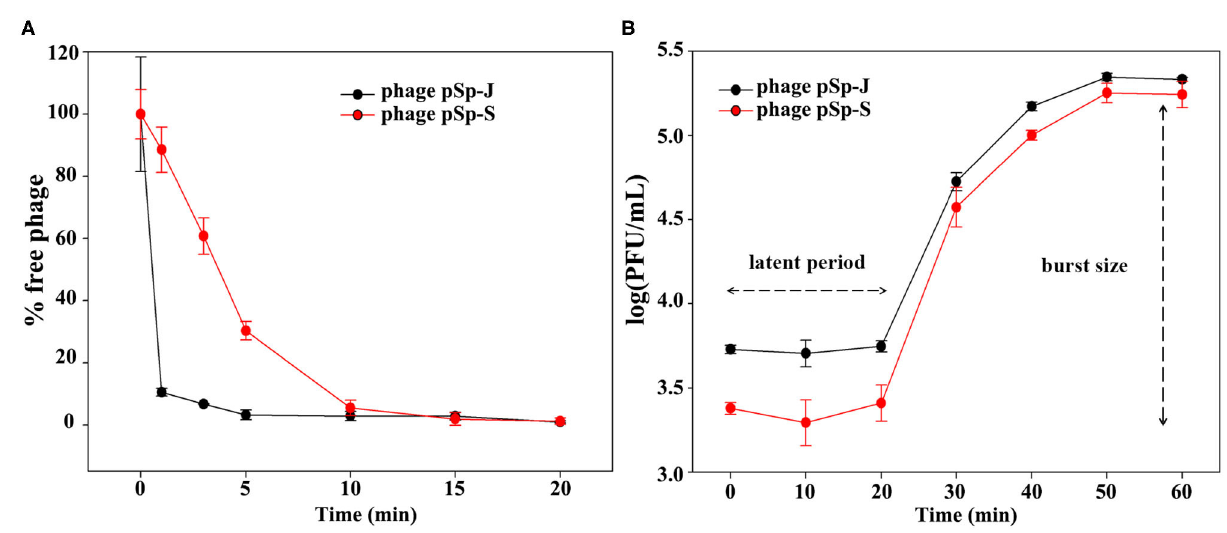
cocktail prevented the formation of biofilm by inhibiting the growth of viable bacterial cells with an inverse concentration- dependent